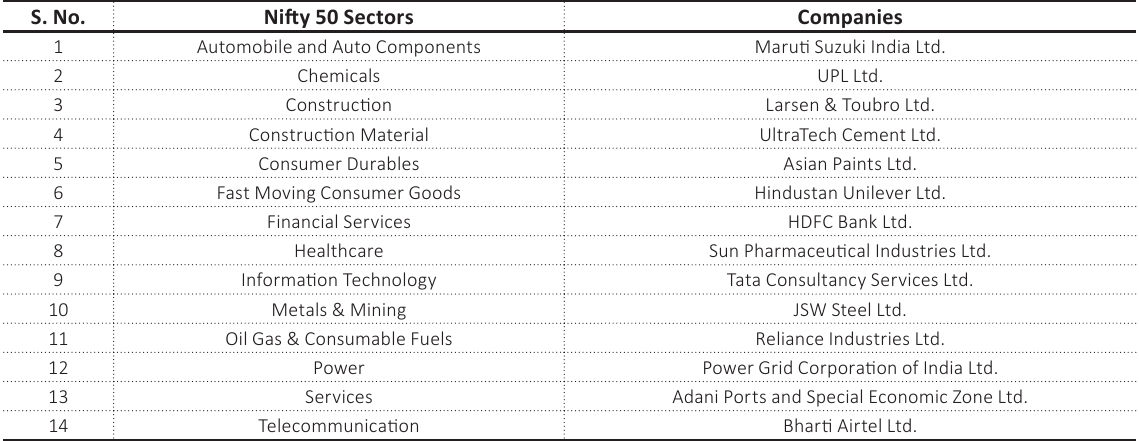
Table A1. List of companies considered for the